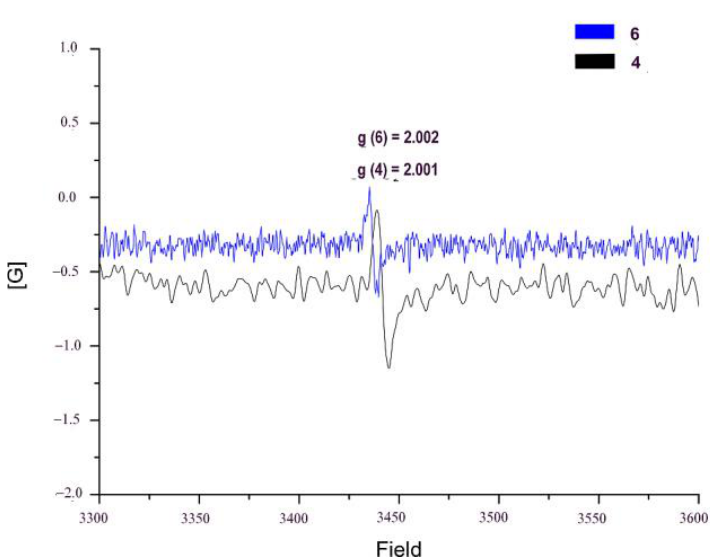
trolyte; scan rate 100 mV s −1 ; Pt-wire as working electrode, Ag/AgNO 3 as reference electrode.